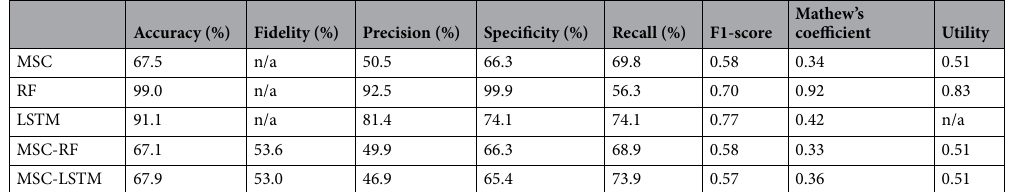
Table 5. Predictive performance of the hybrid models on the same test set.